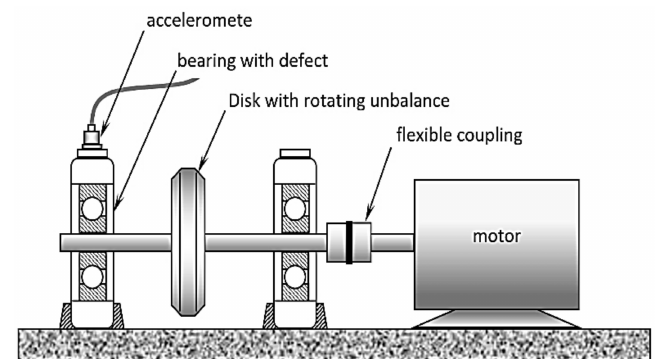
Figure 11. Experimental setup.